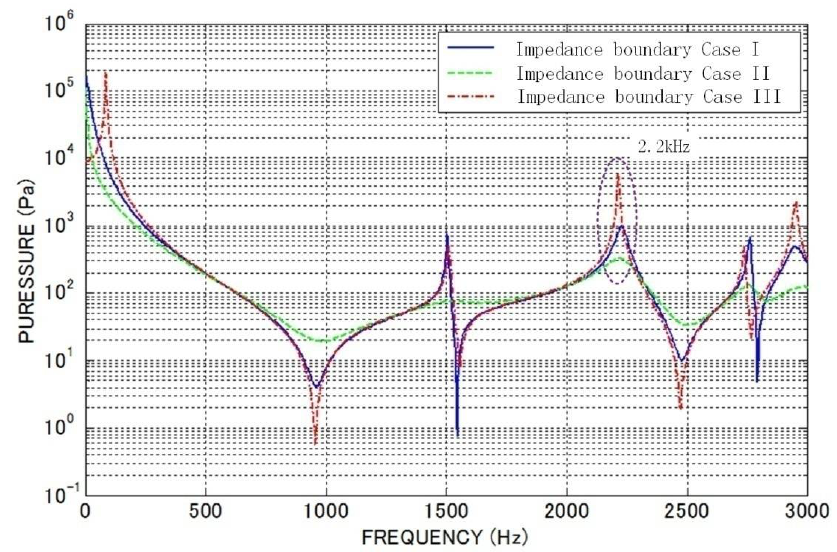
Figure 13. Frequency response curve of water jacket model with different impedance boundaries.